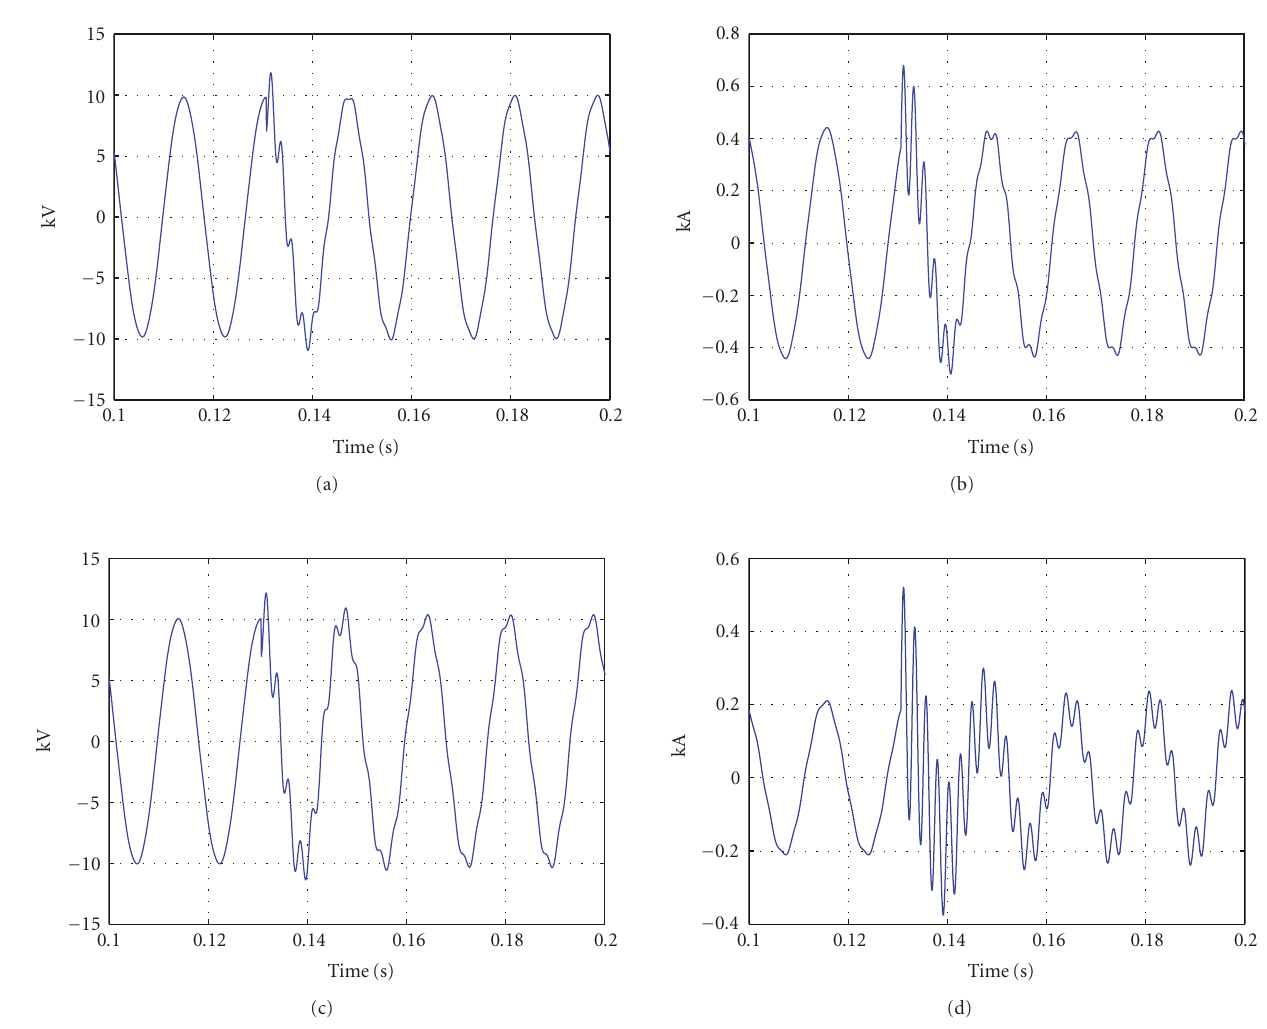
Figure 6: Voltage and current waveforms at a simulated 12.47 kV substation: (a), (b) voltage and current for a system under heavy loading condition and (c), (d) voltage and current when resonance occurs due to loading condition